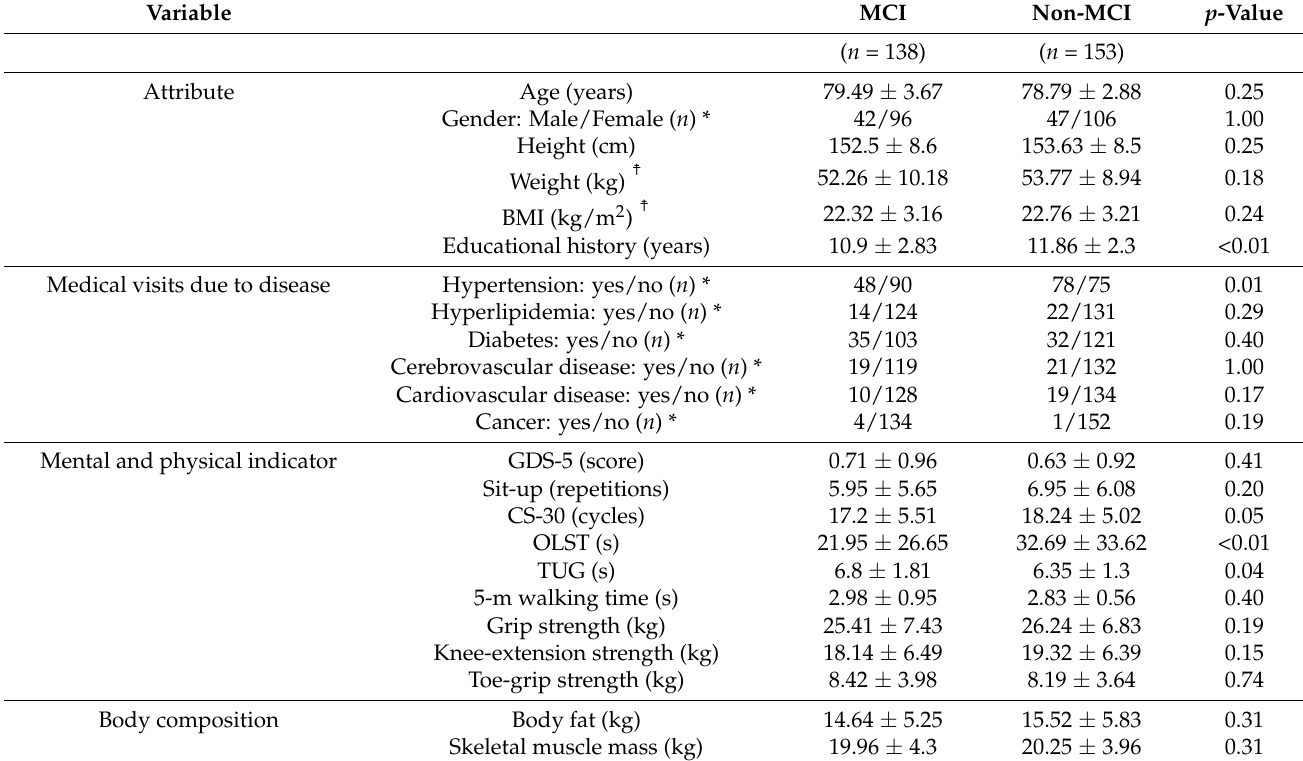
Table 1. Comparison of the fundamental information and measurements between the MCI and non-MCI groups. Variable MCI